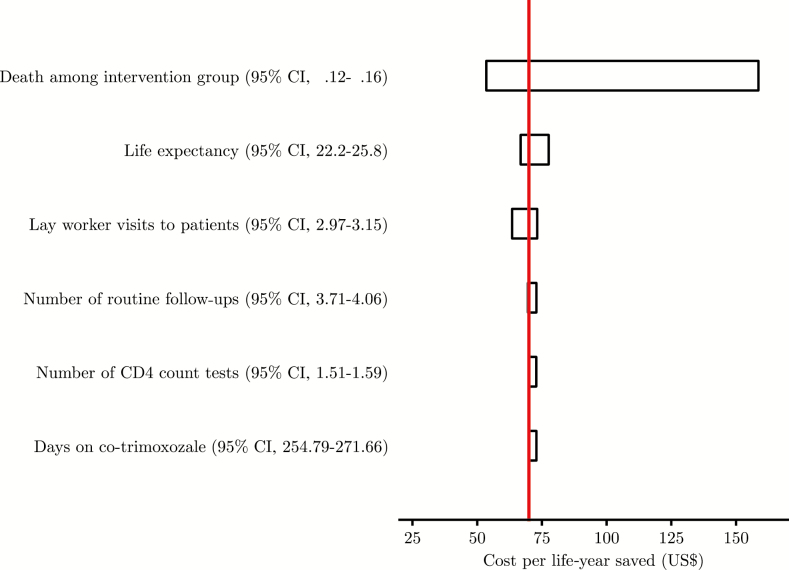
Tornado diagram of change in the base-case incremental cost-effectiveness ratio among persons with CD4 count up to 200 cells/μL produced from a deterministic one-way analysis of 6 input parameters. The ranges used in the sensitivity analysis were based on 95% confidence intervals (CIs) calculated from the Reduction of Early Mortality among HIV-infected Subjects Starting Antiretroviral Therapy (REMSTART) data and previous studies.